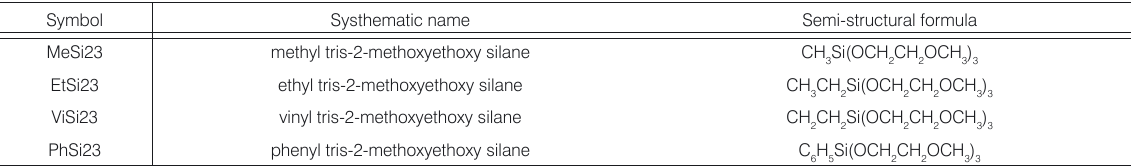
Table 1. Symbols, systhematic names and semi-structural formulas of the silicon tripodand-type